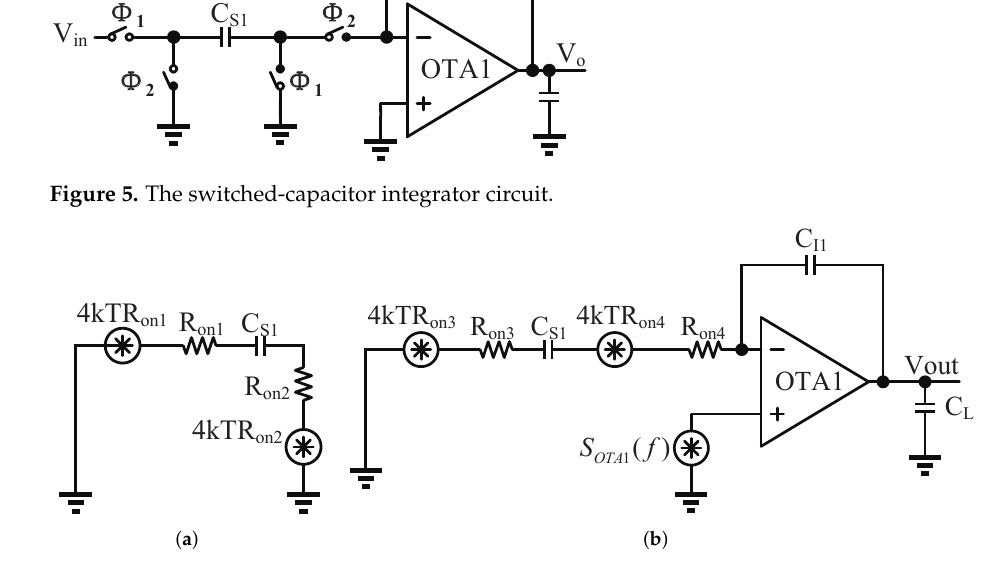
Figure 6. ( a ) Noise model of the sampling phase. ( b ) Noise model of the integrating phase. In the sampling phase ( Φ 1 is on, Φ 2 is off), to make the analysis more specific, the